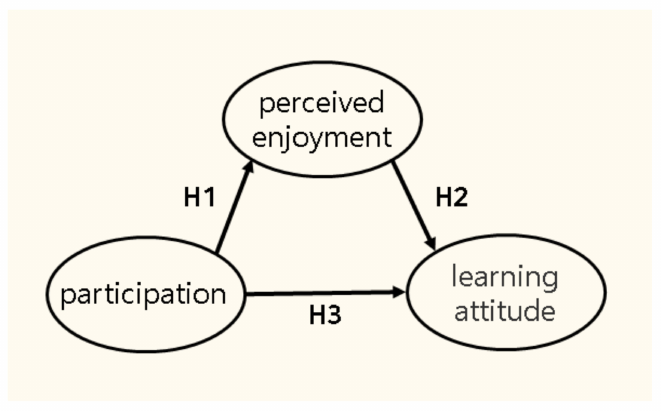
Figure 1. The Conceptual model.